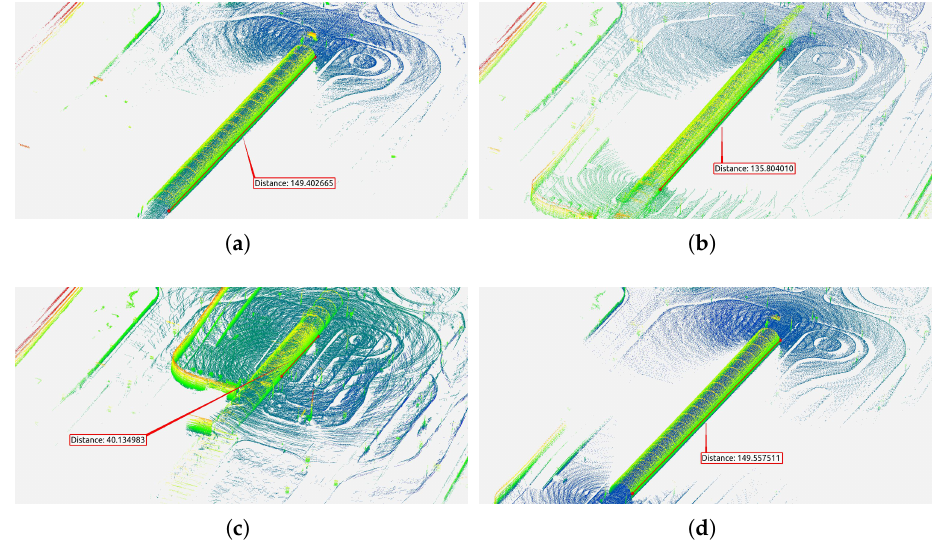
Figure 18. LO systems’ map results on autonomous driving field dataset in the tunnel region.